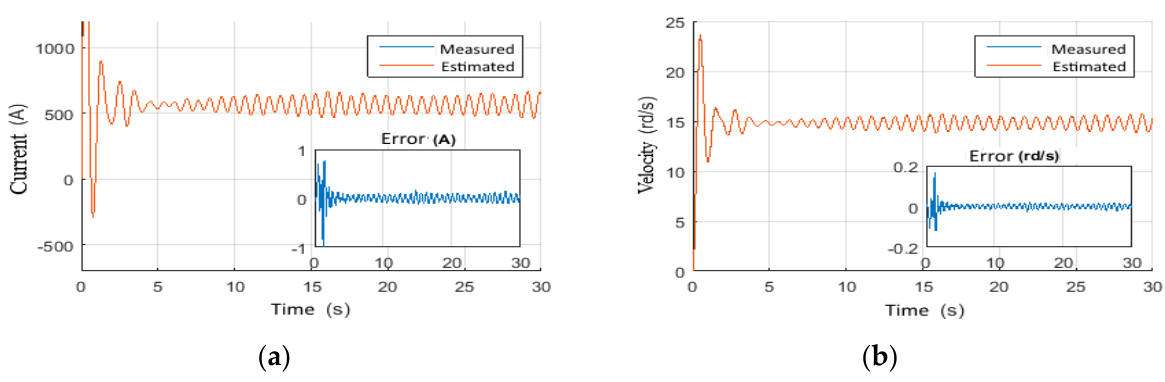
Figure 18. Measured and estimated variables by the designed Observer for Scenario-4: ( a ) Top-drive current, ( b ) Top-drive velocity.